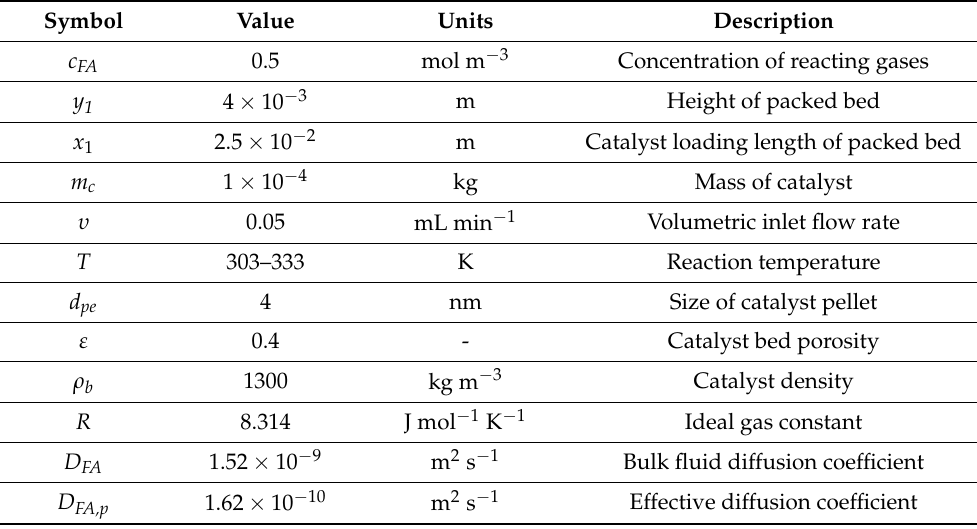
Table 2. Parameters used for the CFD modelling study based on the experimental